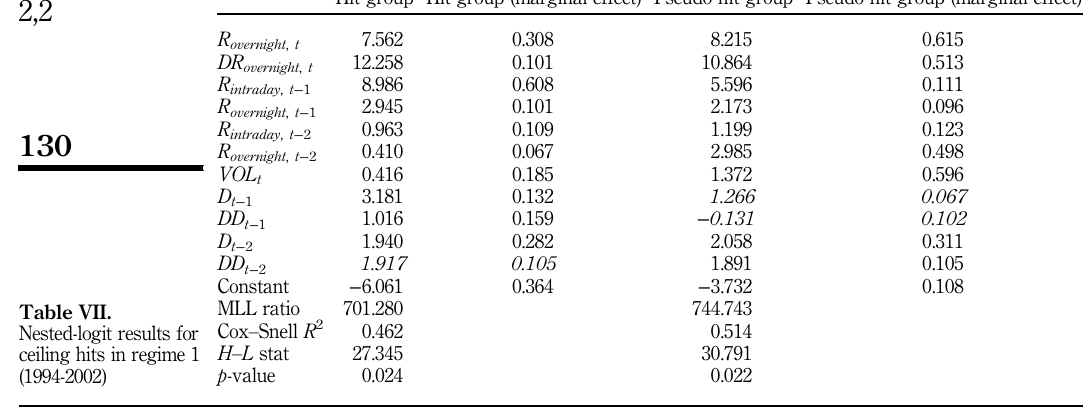
Table VII. Nested-logit results for ceiling hits in regime 1